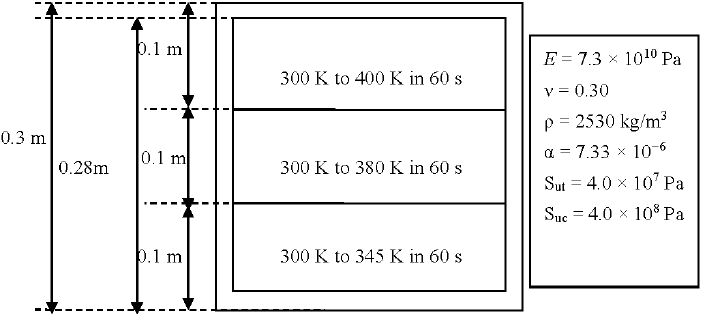
Figure 1. Problem statement of the glass under thermal loading. The glass properties are also reported ([10–13]).